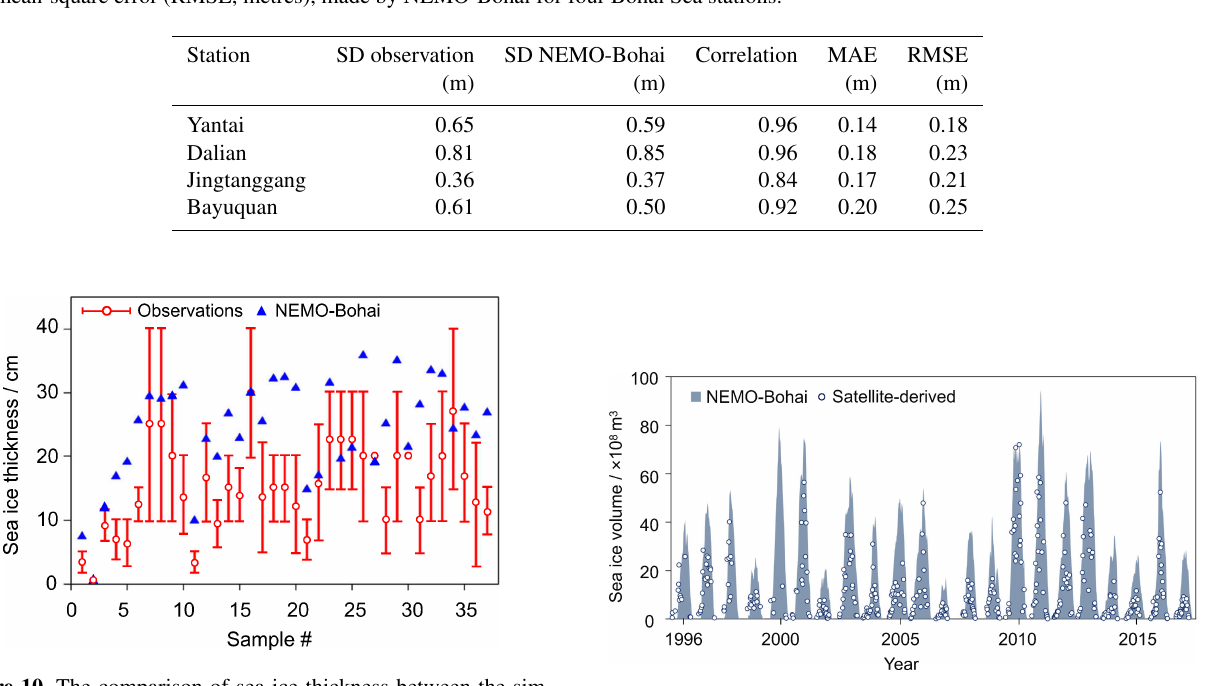
Figure 9. Comparison of the spatial distribution of sea ice from NEMO-Bohai simulation and remote sensing inversion in freeze, severe freeze, and thaw periods for light (a–f) , normal (g–l) , and heavy (m–r) ice years. Table 2. Sea surface height representation, in terms of standard deviation (SD, metres), correlation, mean absolute error (MAE, metres), and root-mean-square error (RMSE, metres), made by NEMO-Bohai for four Bohai Sea stations.